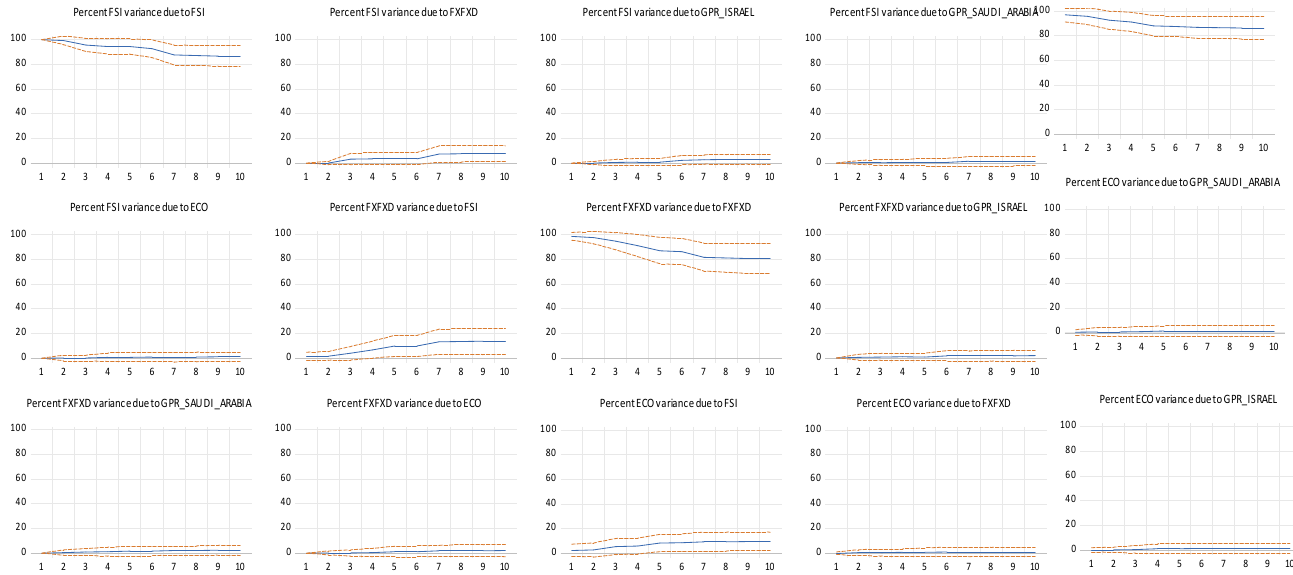
Figure 5. Variance decomposition of variables.